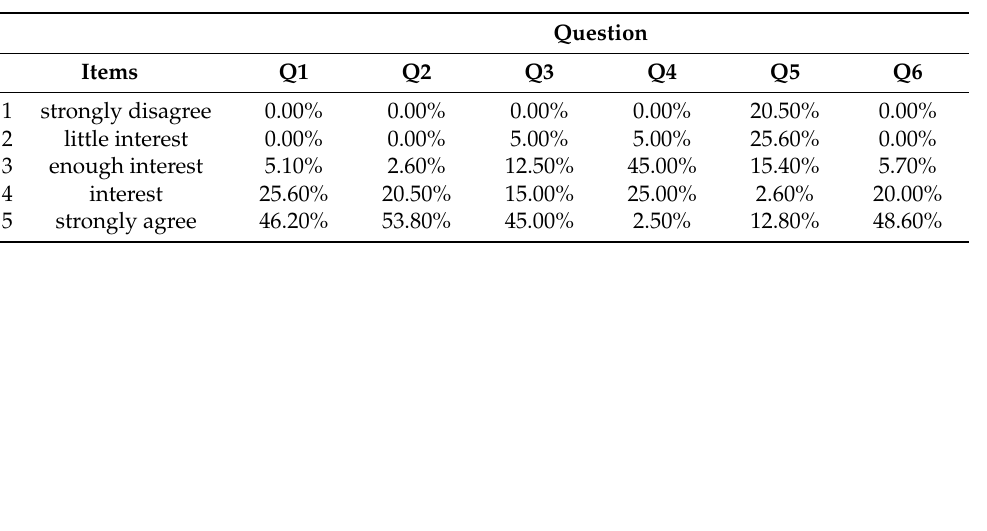
Table 6. The satisfaction level response proportion of girls < 12 years old (primary